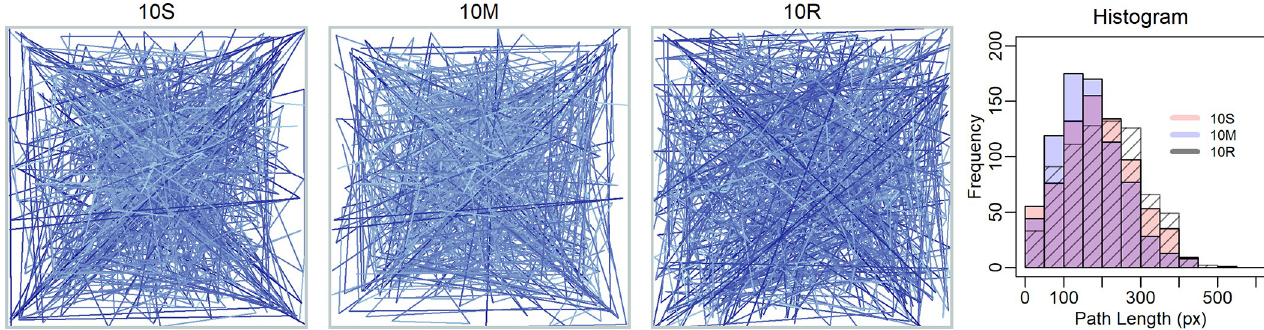
Fig 3. Line patterns resulting from connecting successive dots for each participant in the two conditions in Experiment 1, and for the random-dot pattern (10R). The blue gradient of the lines indicates their length: The longer the line the darker the blue. The corresponding histograms are shown in the outermost panel on the